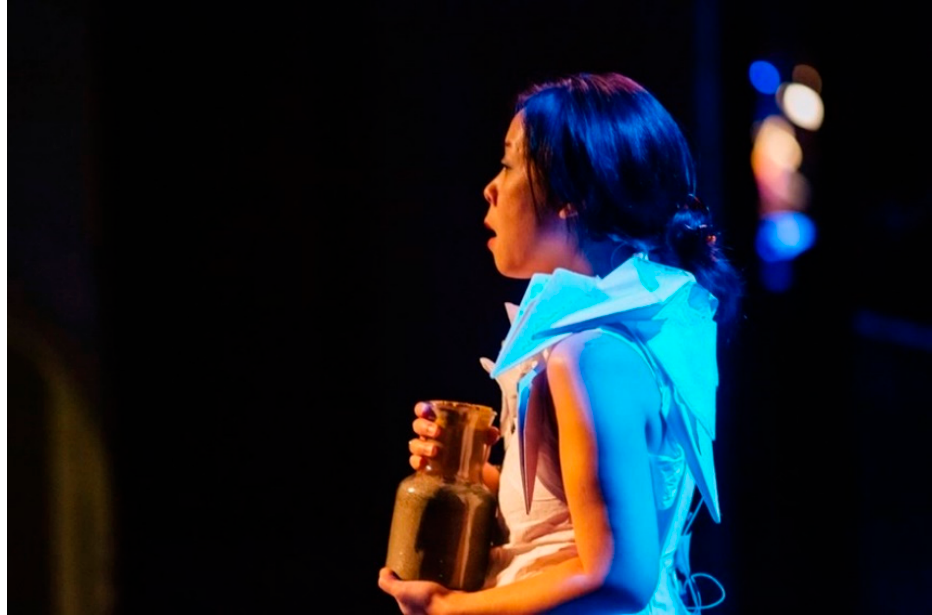
Figure 12. Shin Yu Pai holding a glass vessel of sand from Carkeek Beach at the Moore Theater. Image courtesy of Forterra.